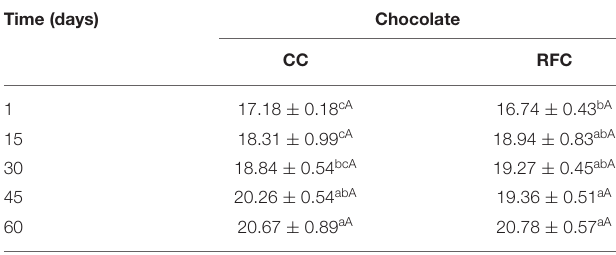
TABLE 2 | Whiteness index of chocolate samples during the stability study (samples stored at 24 1 ◦ ±